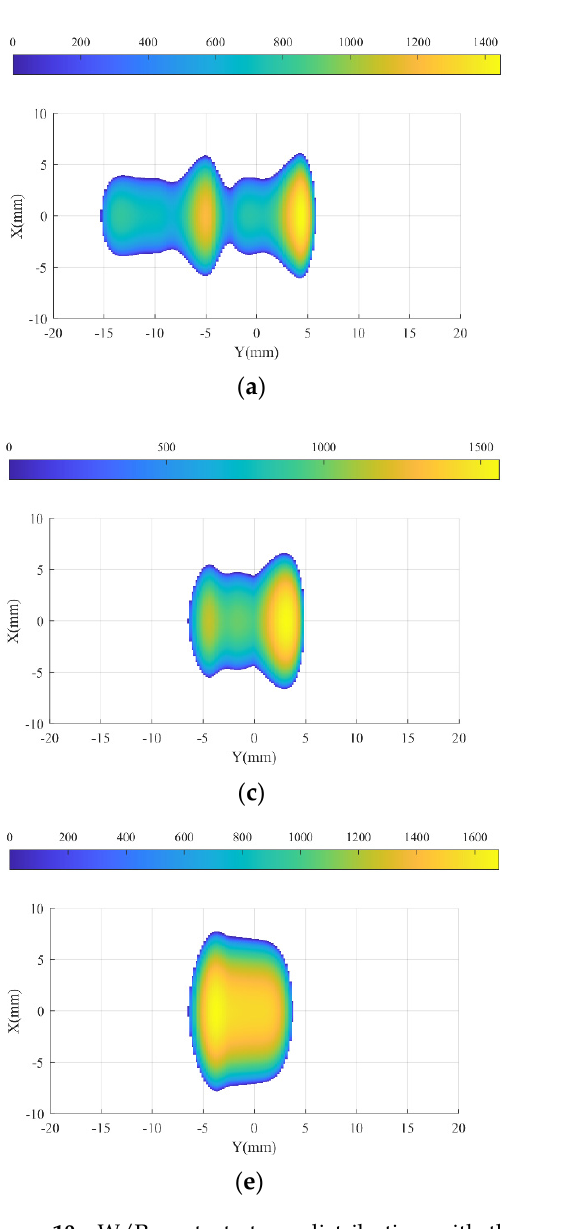
Figure 10. W/R contact stress distribution with the semi-Hertzian method considering non-elliptical contact patch: ( a ) normal contact stress in a straight line; ( b ) traction coefficient in a straight line; ( c ) normal contact stress in a transition curve; ( d ) traction coefficient in a transition cure; ( e ) normal contact stress in a curve section; ( f ) traction coefficient in a circular curve.